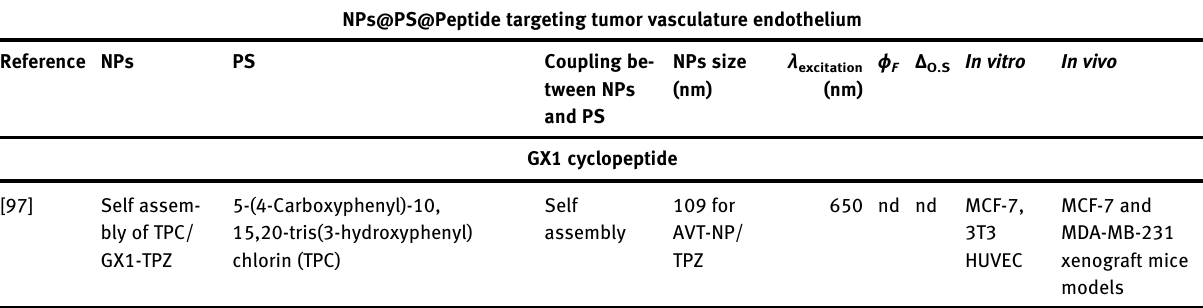
Table  : The summary of NPs conjugated with PSs peptides targeting tumor vasculature endothelium in terms of different parameters.